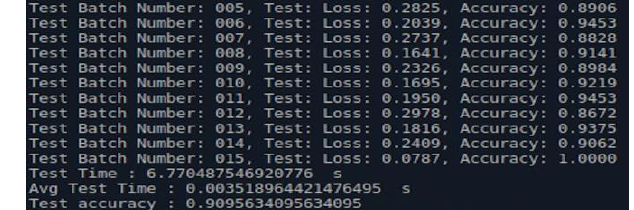
Fig. 3. Model test